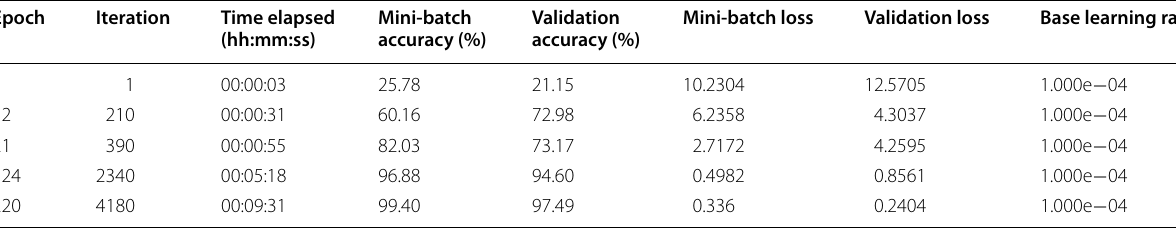
Table 4 Computational training time of the Alexnet deep learning